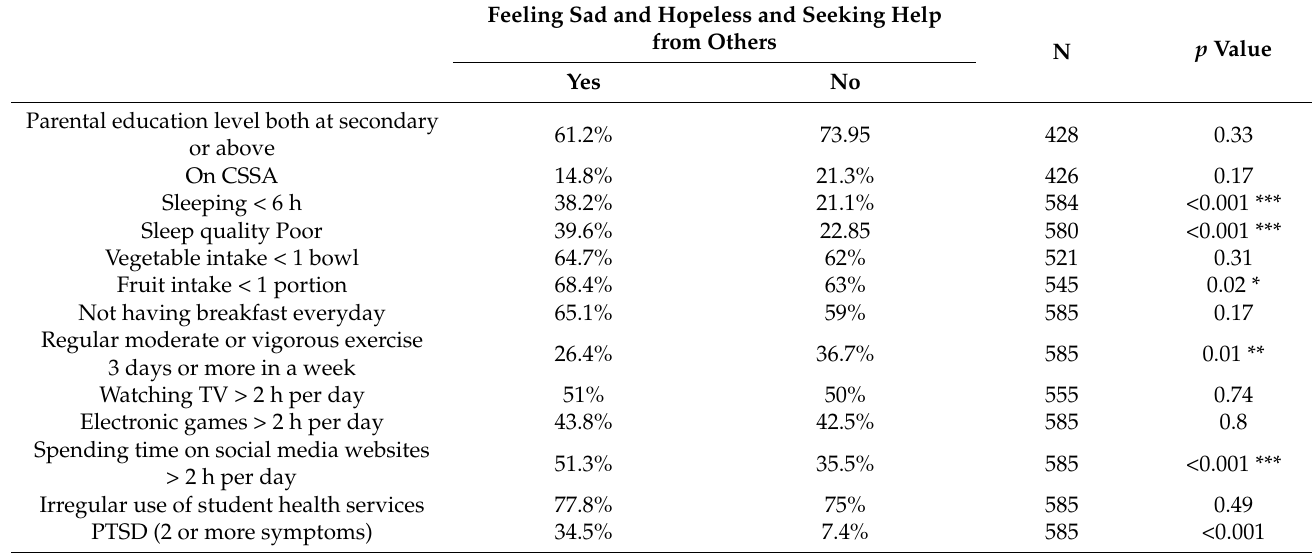
Table 3. Correlations between emotional status and living habits, lifestyles, and health status. Feeling Sad and Hopeless and Seeking Help from Others N